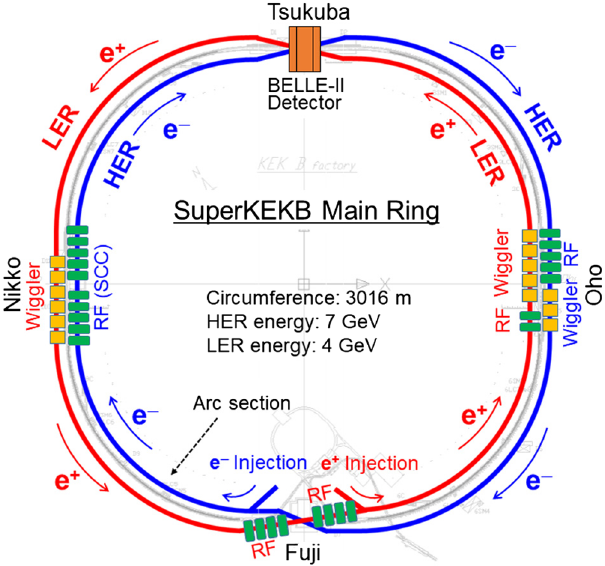
FIG. 1. Layout of the SuperKEKB main ring (MR). One ring consists of four arc sections and four straight